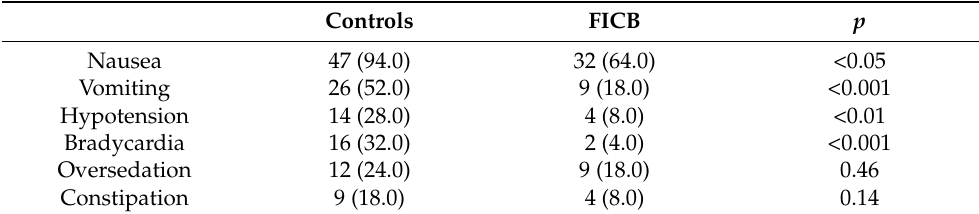
Table 2. An inter-group comparison of the incidence of postoperative adverse events.